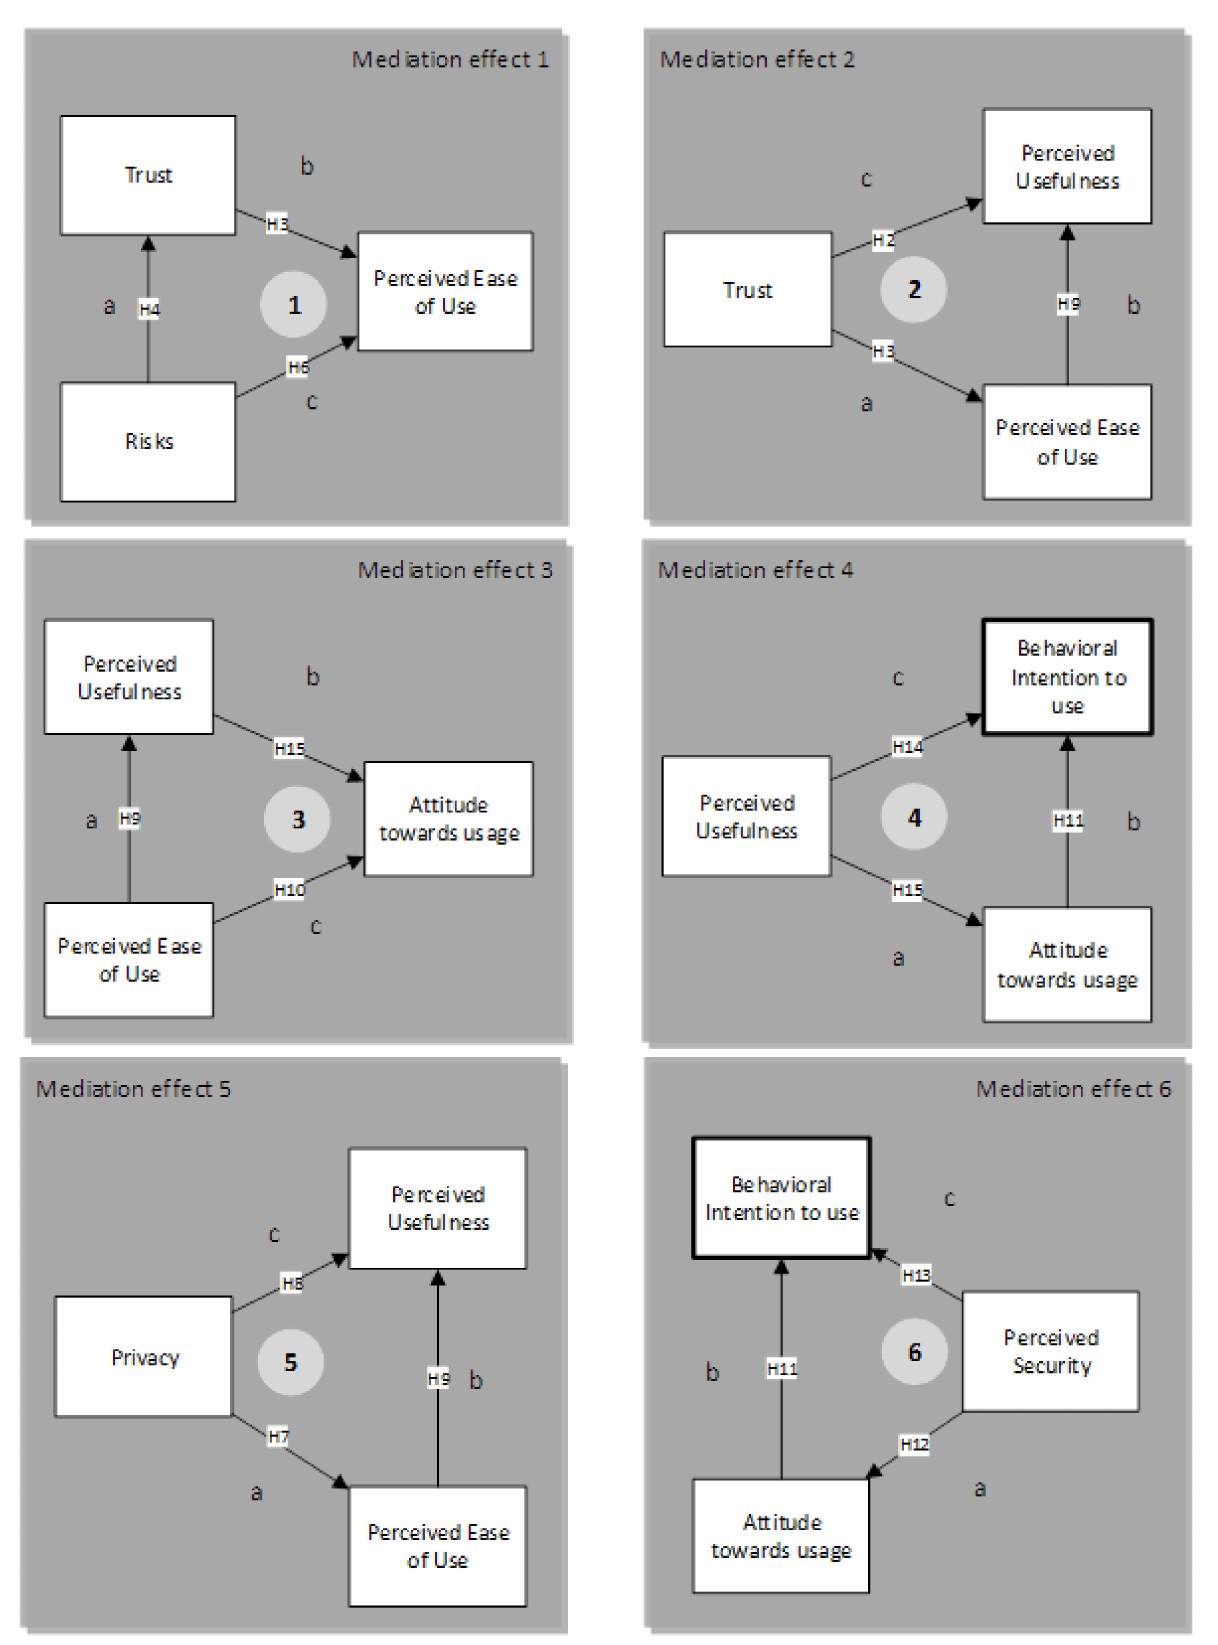
Figure 6. Mediation